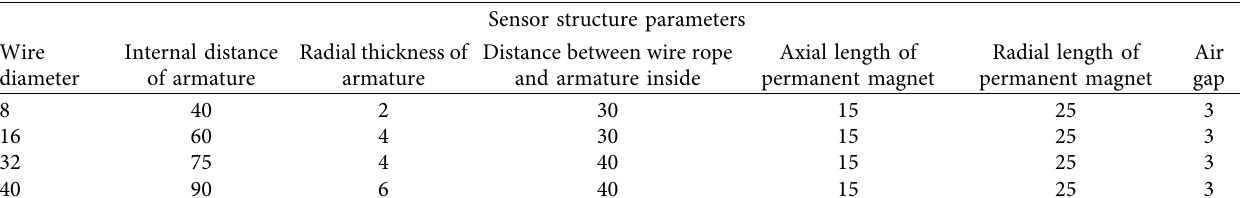
Figure 7: The structure diagram of the detection Table 1: Dimensions of each part of the sensor.